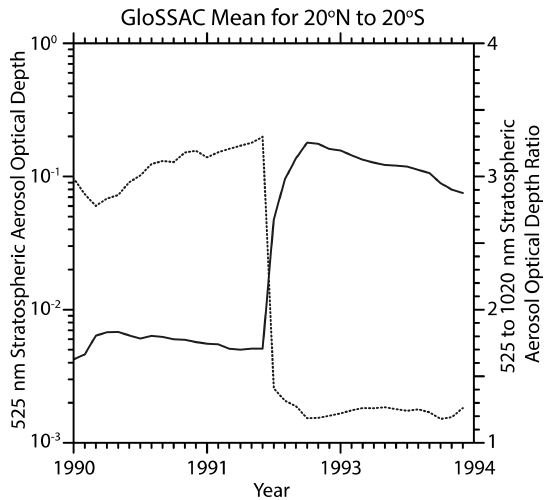
Figure 3. The GloSSAC v2.0 depiction of the 525nm aerosol op- tical depth (solid) and the 525 to 1020nm stratospheric aerosol op- tical depth ratio (dotted) for 1990 through the end of 1993, encom- passing the Kelut eruption in early 1990 and the Mt. Pinatubo erup- tion in